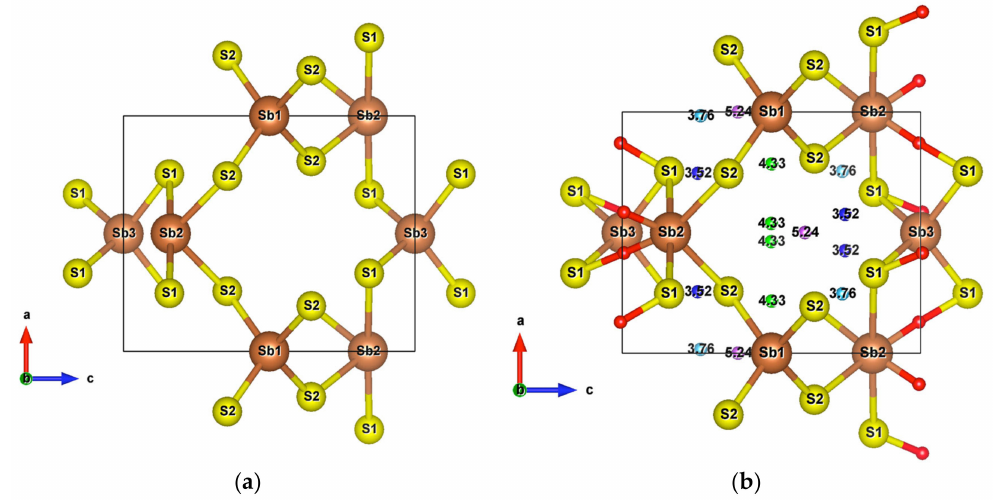
Figure 8. ( a ) Unit cell of SbS 2 ; ( b ) Crystal structure of SbS 2 showing weak interactions. The red small balls are BCPs of Sb–S interactions and the remaining with other colors are BCPs of S–S